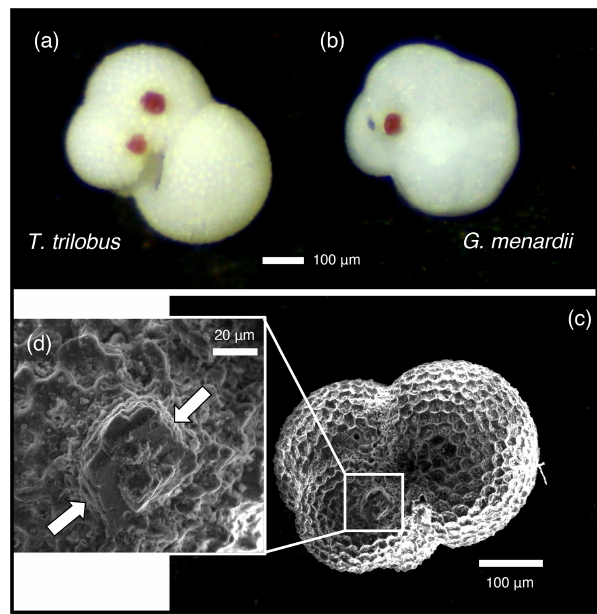
Figure 1. Crystal overgrowths were identified on both pre-ASE and ASE samples from ODP 926B, possibly a host phase for the anoma- lously high Mn ( > 400µmolmol − 1 Mn / Ca) observed in these sam- ples, shown here on non-treated specimens of (a) T. trilobus and (b) G. menardii. (c) SEM image of ASE-treated T. trilobus with crys- talline overgrowth shown in white box and (d) close-up identified by white